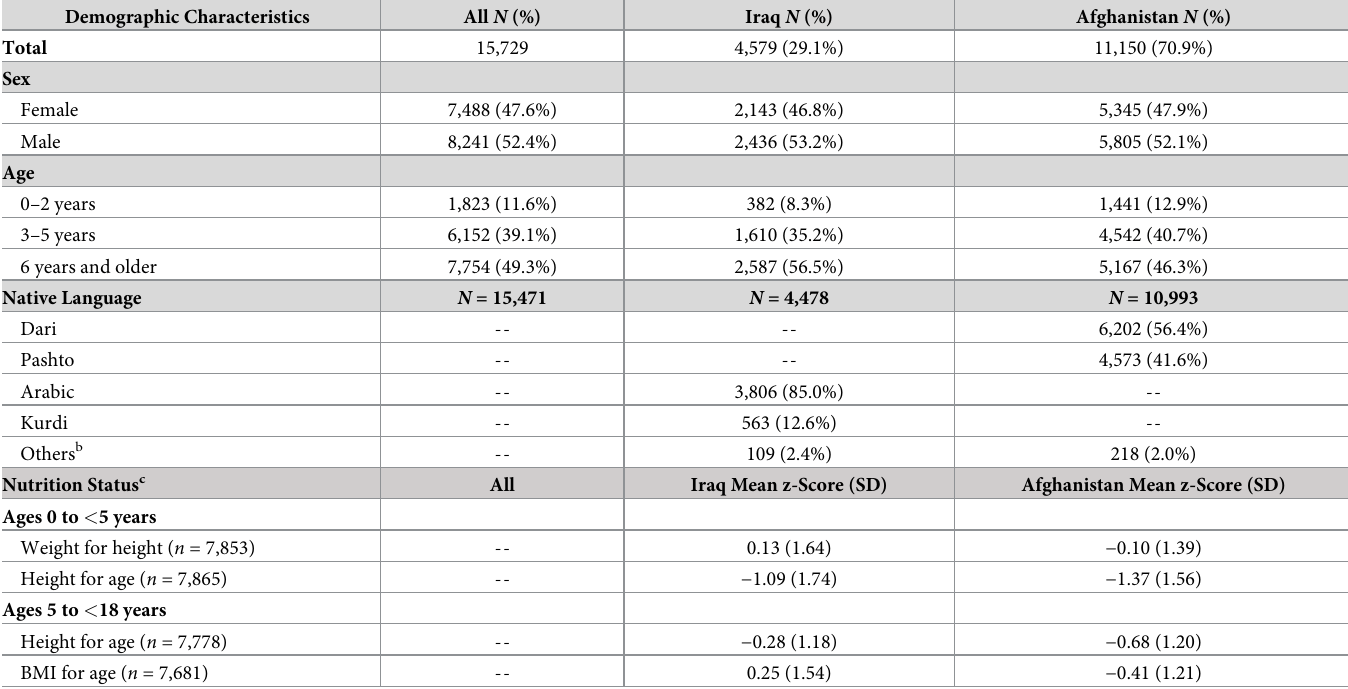
Table 1. Demographic characteristics and nutrition status of SIVH children less than 18 years resettling to the US, 2009–2017 ( n = 15,729) a . Demographic